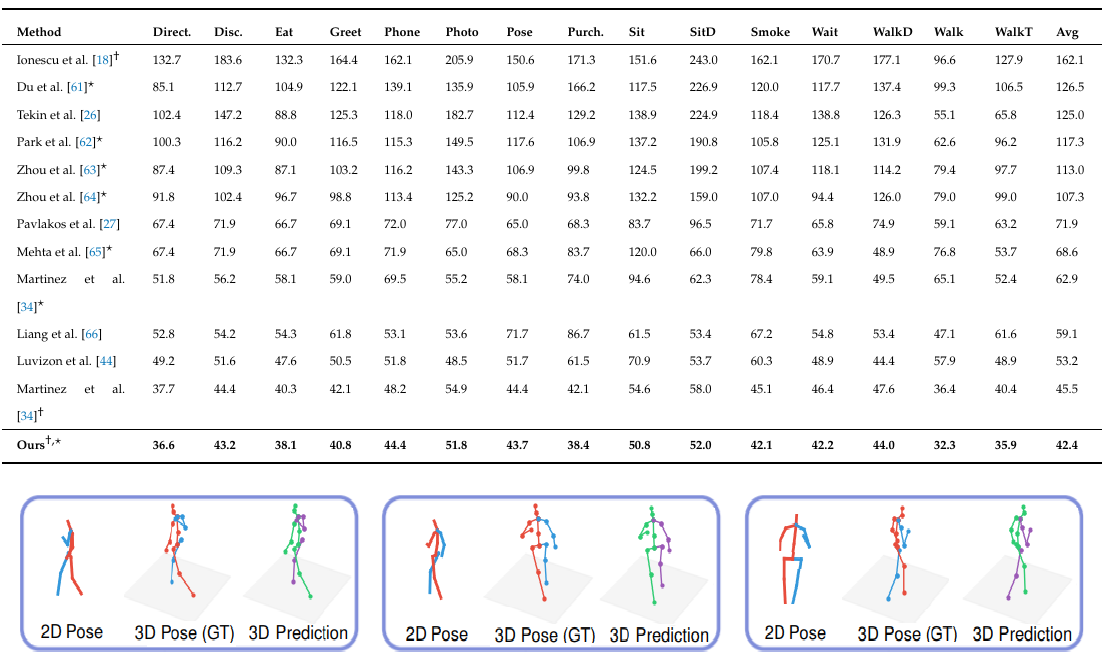
Table 1. Experimental results (average error in mm) and comparison with previous state-of-the-art 3D pose estimation approaches on the Human3.6M dataset [18]. The symbol (cid:63) denotes that a 2D detector was used and the symbol † denotes the ground truth 2D joint locations were used.